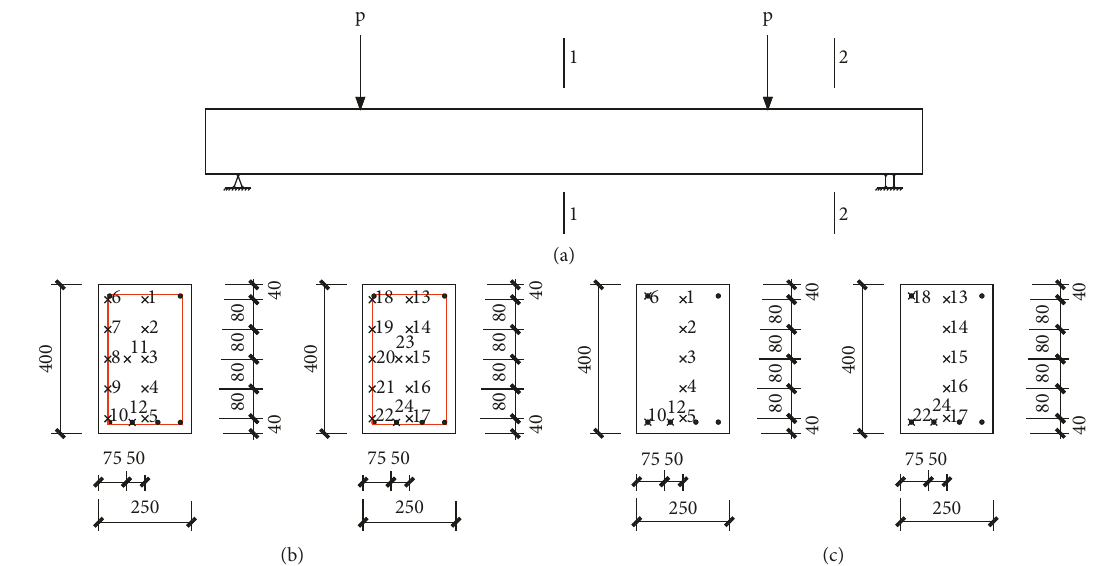
Figure 3: Location of thermocouples (dimensions in mm). (a) Elevation; (b) B2, B3, B4, and B5; (c) B6.